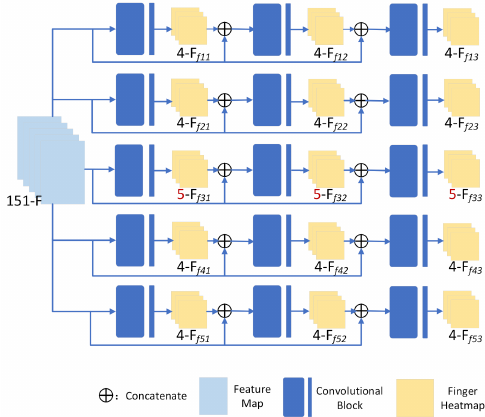
Figure 3. The architecture of the hierarchical estimation network. Five 2D single finger heatmaps are estimated by the network, of which n -F fij represents the n -channel 2D heatmaps of the i th finger estimated by j th